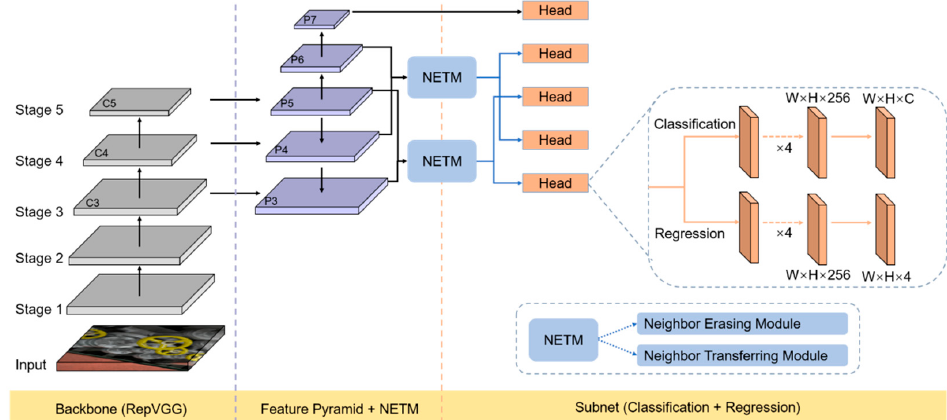
Figure 2. Illustration of the proposed framework.